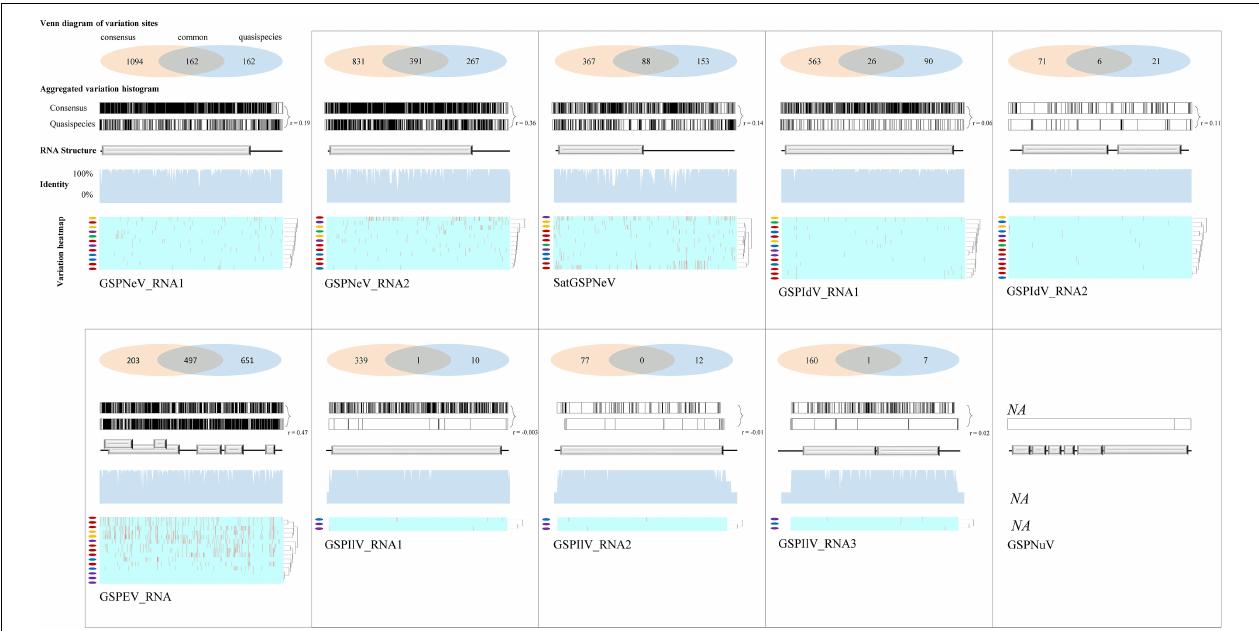
FIGURE 4 | Variation sites pattern analyses of viral/subviral RNAs. Green Sichuan pepper-nepovirus (GSPNeV), -idaeovirus (GSPIdV), -enamovirus (GSPEV), -nucleorhabdovirus (GSPNuV), -nepovirus large linear satellite RNA (satGSPNeV), and -ilarvirus (GSPIlV). For each RNA, as each diagram shows, variation sites among the consensus sequences from the read mapping of different samples to reference isolates from CQ1-D and CQ7-DS or aggregated from comparisons of each consensus sequence with their own quasispecies were calculated (the Venn diagram) and visualized (the variation histogram). The common variation sites between the consensus sequences and quasispecies were also determined, and the counted numbers shown for the consensuses and quasispecies are unique. The plots for sequence identity among the consensus sequences are shown (the identity histogram). The variation heatmap at the bottom shows the clustering of the samples by variation site distributions of their quasispecies, and the quasispecies from the same geographical locations are indicated with the same colored circles.